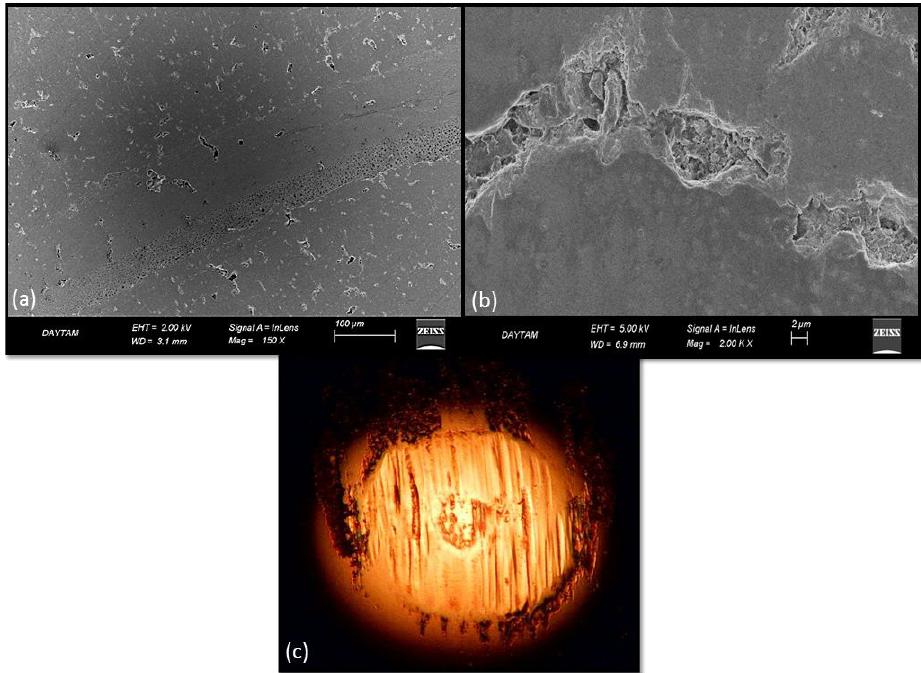
Figure 4. SEM images of the wear scar of samples a,b) equimolar TiNbZr alloy; c) counter-material surfaces.